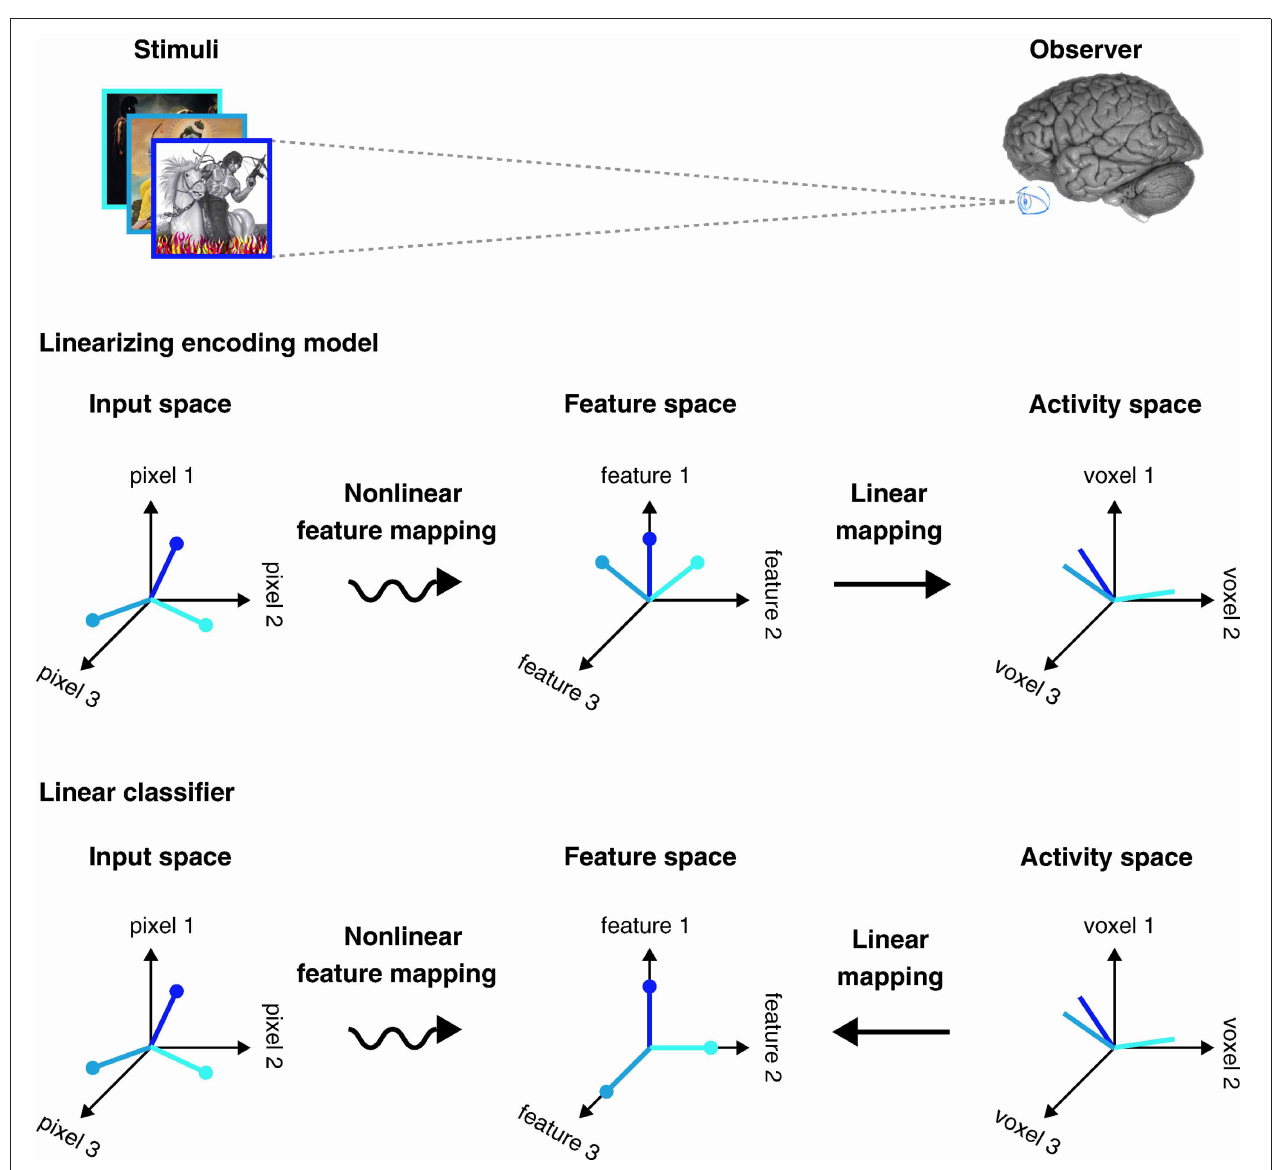
FIGURE 1 | Linearizingencodingand decodingmodels. Top: Thebrain can be viewedas asystem that mapsstimuli onto brain activity in a nonlinear fashion. Accordingto thisperspective,a central task of systems andcognitive neuroscienceis to discover thenonlinear mappingbetweeninput and activity. Middle: Linearizing encodingmodel.Therelationship betweenencodingand decodingcan be describedin terms of a seriesof abstract spaces. In experimentsusingvisual stimuli, theaxesof theinputspaceare theluminance of pixels and each point in the space (heredifferent colorsin the inputspace) representsa differentimage. Brain activity measuredin each voxelis representedbyan activity space. Theaxesof theactivity space correspondto